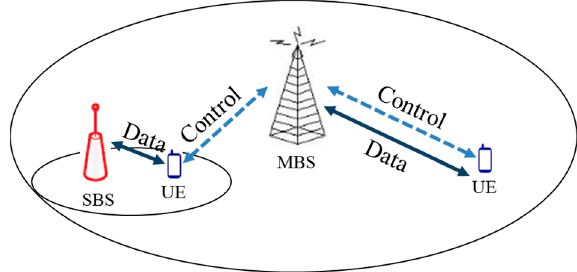
Figure 3. Separated data and control architecture.